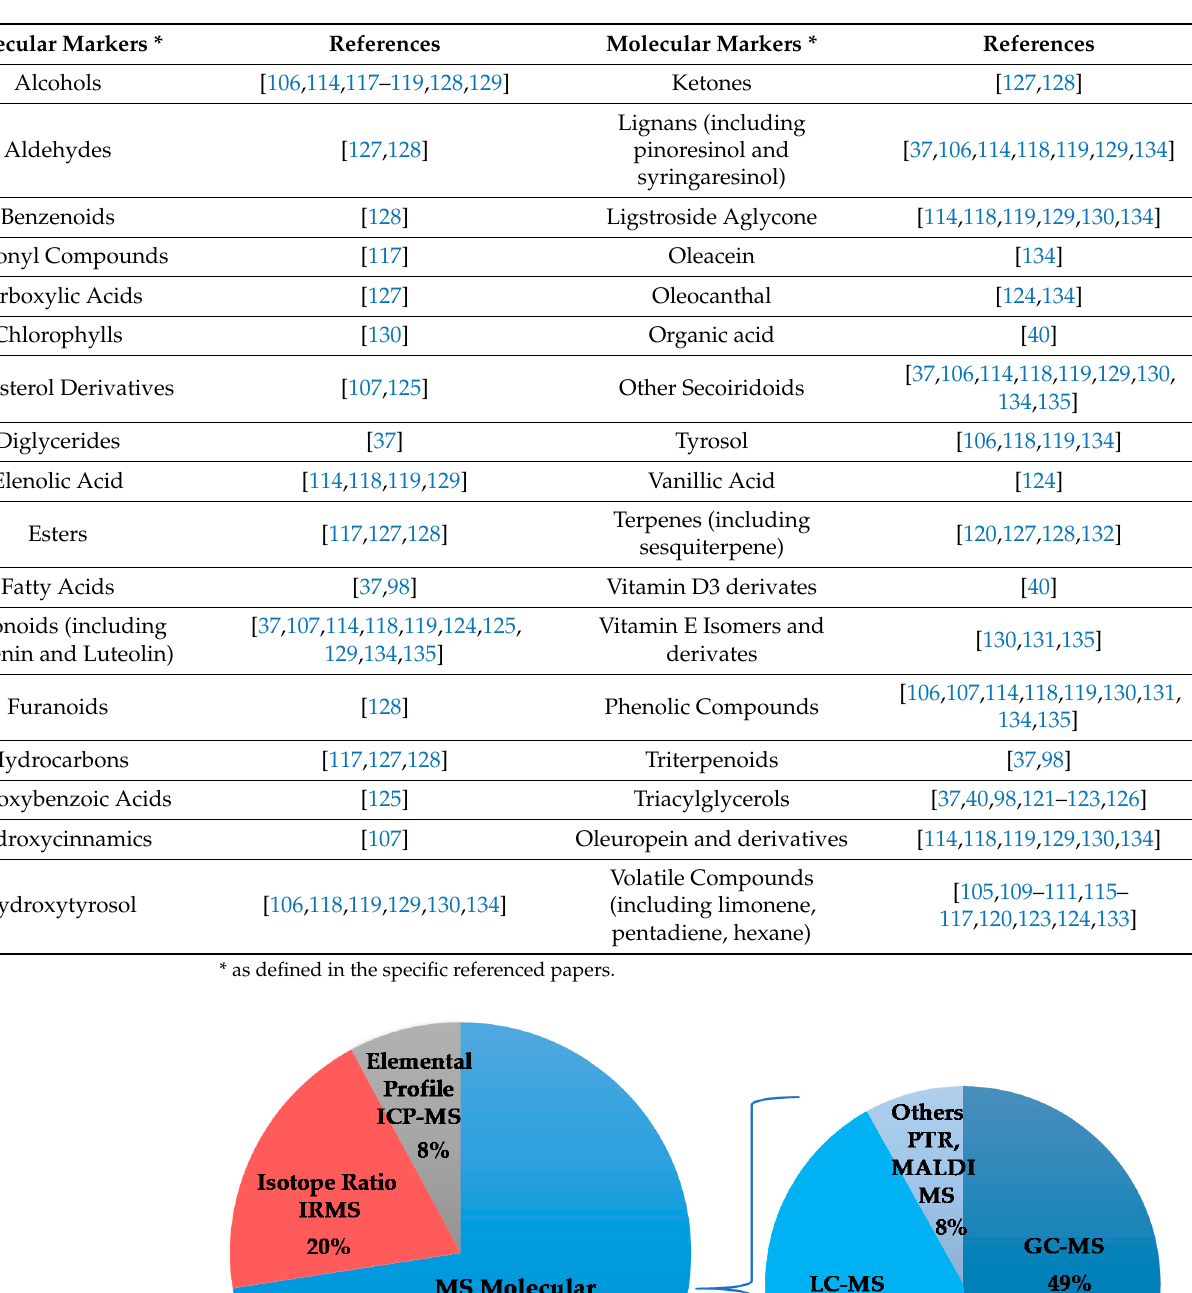
Table 5. Key molecular markers identified in MS studies of Table 4.